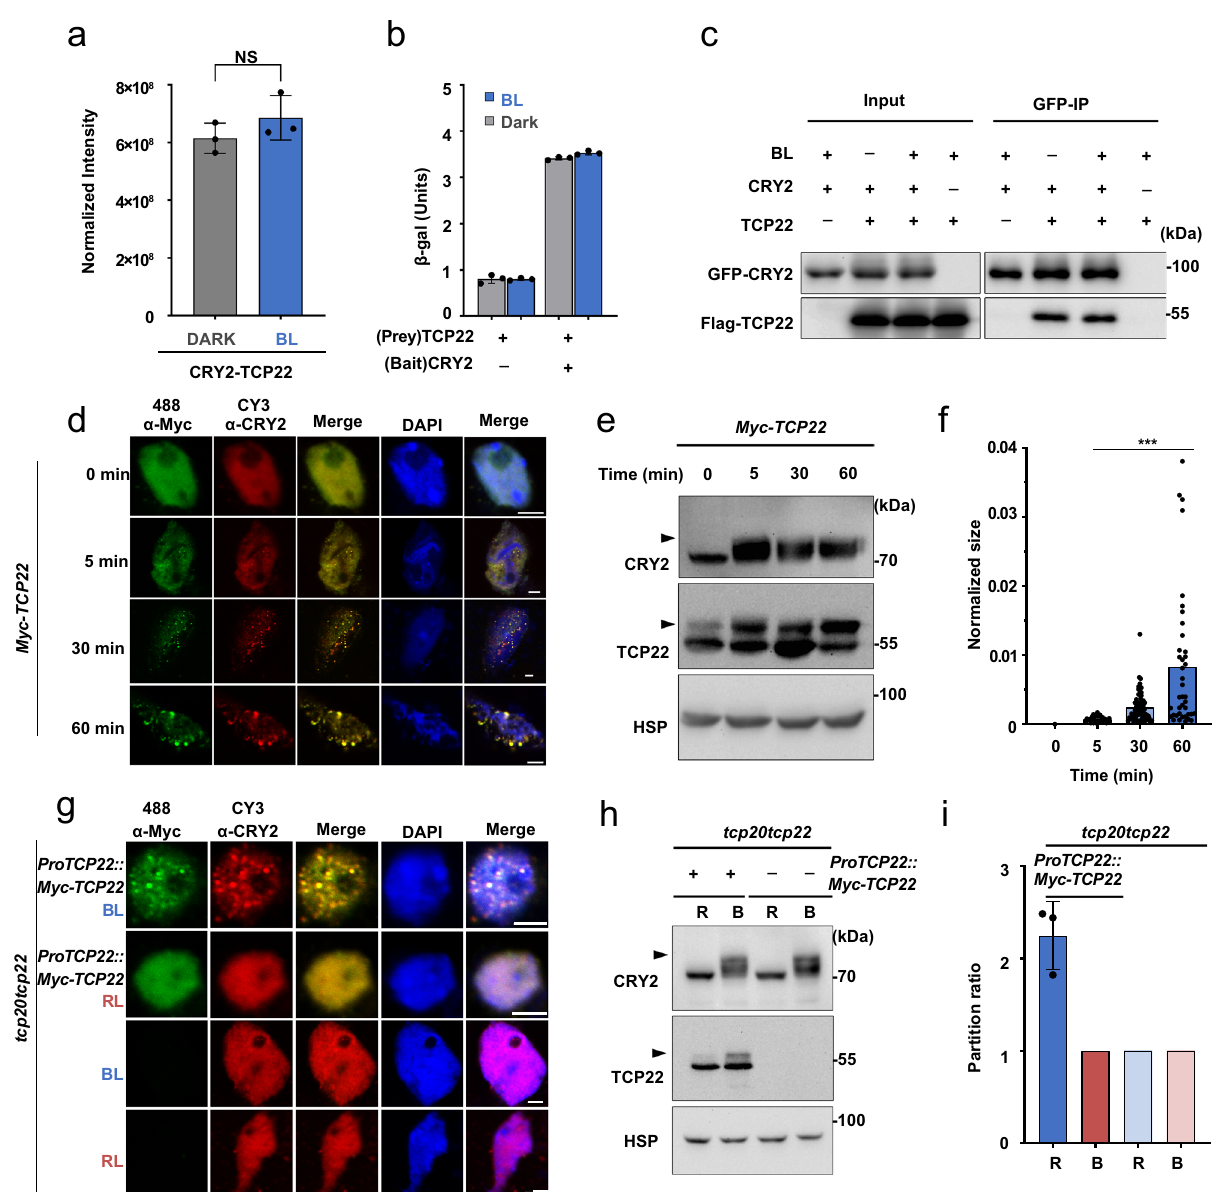
Fig. 1 CRY2 and TCP22 exhibit blue-light-independent interaction but blue-light-dependent photobody formation. a Mass Spectrometry analysis showing the interaction of CRY2 and TCP22 in vivo. Normalized intensity of three biological replicates from dark and blue light (BL, 30 μ mol m − 2 s − 1 ) treated seedlings, respectively. Two-tailed student ’ s t-test was used for statistical tests. Data are presented as mean ± SD ( n = 3